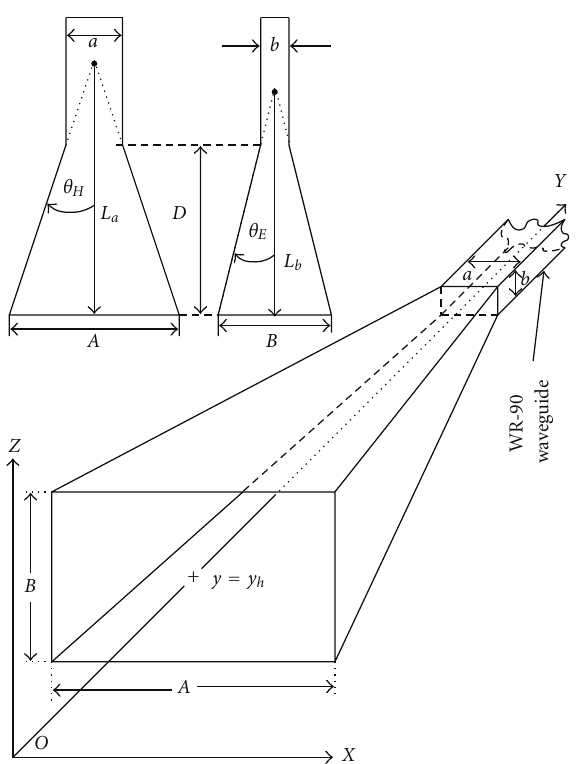
Figure 1: Details of geometry of a pyramidal horn antenna.